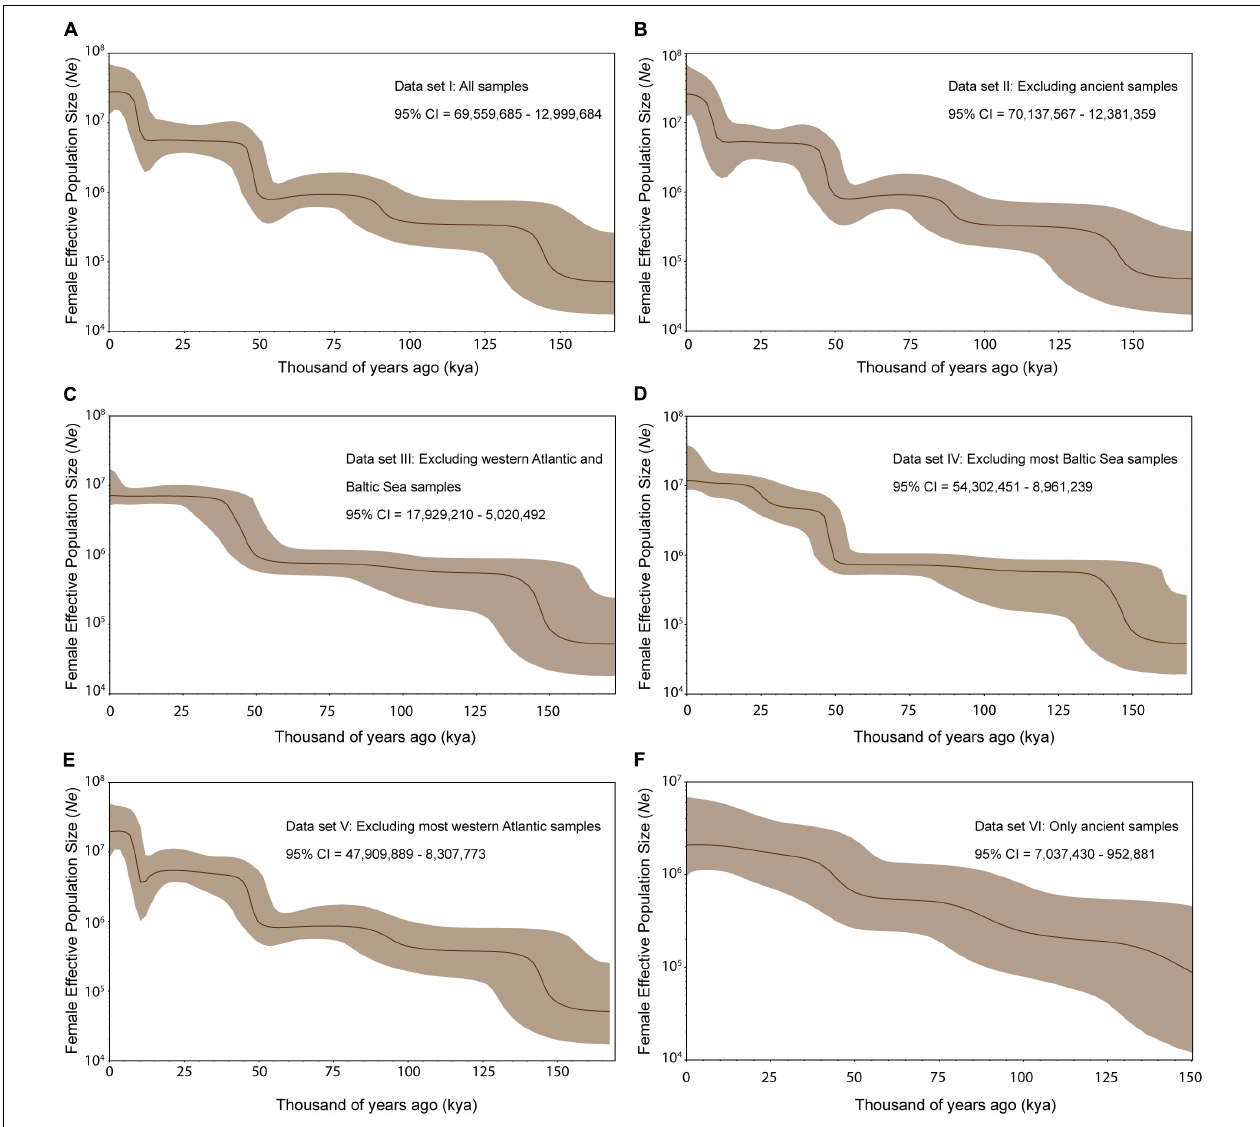
FIGURE 5 | Atlantic cod demographic history representing the fluctuations of effective female population size ( Ne; in dark brown line) based on (A) data set I: all 524 sequences, (B) data set II: 476 modern sequences (excluding 48 ancient samples), (C) data set III: 273 sequences (excluding clades associated with most western Atlantic and Baltic Sea samples), (D) data set IV: 368 sequences (excluding the clade associated with most Baltic Sea samples), (E) data set V: 429 sequences (excluding clades associated with most western Atlantic samples) and (F) data set VI: 48 ancient sequences (excluding all modern samples). The 95% CI corresponds to the light brown area. The most recent 95% CI at time 0 is shown in each respective panel. Description of the clades excluded in data sets III, IV, and V can be found in Supplementary Figure 7